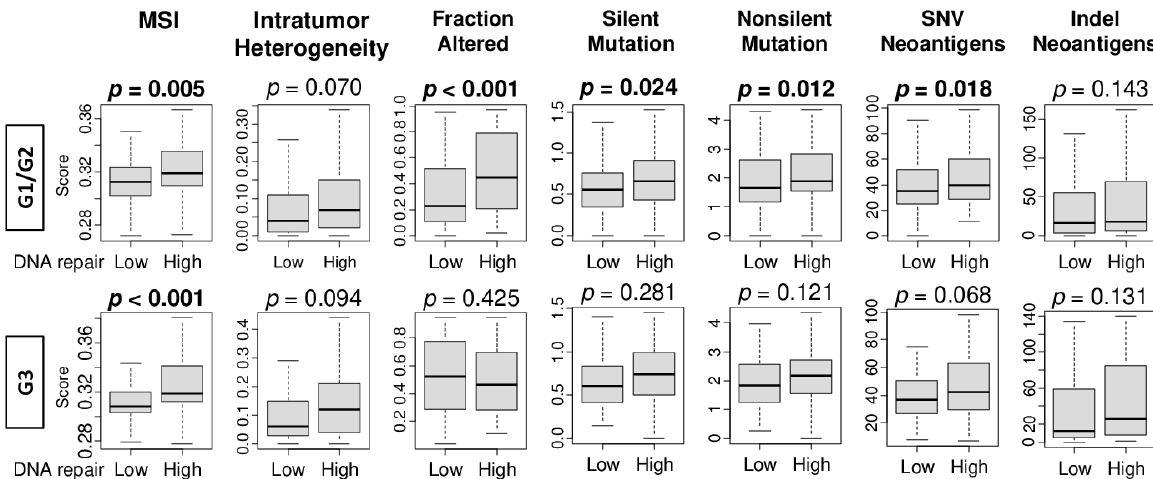
Figure 5. Association of the DNA repair score with microsatellite instability (MSI), intratumor heterogeneity, as well as mutation load by pathological grade 1 and grade 2 (G1/G2) and grade 3 (G3) in the TCGA cohort. Boxplots demonstrate either MSI, intratumor heterogeneity, and mutation-related scores, including the fraction altered, silent and non-silent mutation, single-nucleotide variants (SNV) and indel neoantigens, by low or high DNA repair score in grade 1 and 2 (G1/G2) and grade 3 (G3). The p -value was calculated using the Mann–Whitney U test. Bold format: significant p values.